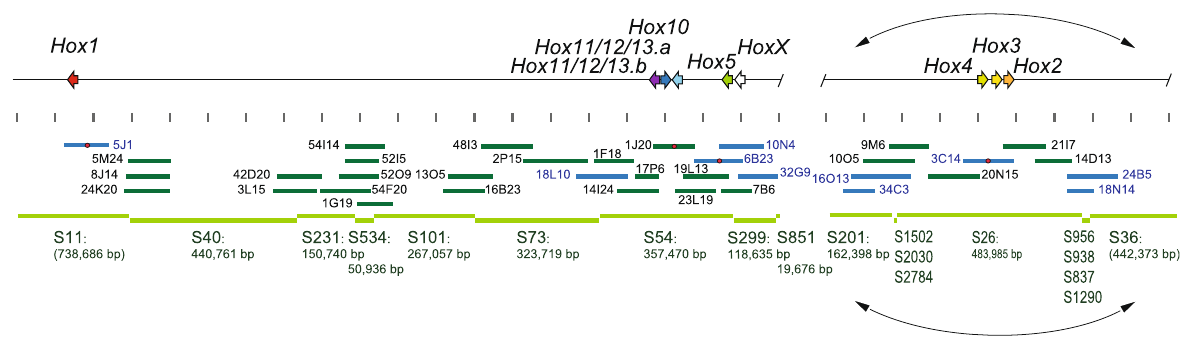
Fig. 4 Schematic representation of the Hox gene cluster of Halocynthia roretzi . The Hox gene cluster structure of Hr as estimated by chromosome/ scaffold walking is shown at the top. A horizontal line represents a part of chromosome. The telomeric side is to the left and the centromeric side is to the right. Hox genes are represented as thick arrows, which also indicate transcription direction. The color code is the same as that in Fig. 1. Between HoxX and Hox4, there is a region, from which no clones were available out of the BAC library; hence, no scaffolds available out of the ANISEED database. Grey arrays of short vertical bars indicate 100 kbp, starting at the right and left ends of the region where no scaffolds are available. Dark green or blue horizontal bars below the scales indicate BAC clones corresponding to Hox gene clusters. Dark green bars indicate BAC clones, end regions of which were sequenced. Blue bars indicate BAC clones for which the whole insert sequence was determined. Bars with red dots in the middle are the clones used for probes for chromosomal FISH (Fig. 3). Names of clones are also indicated. Green horizontal bars at the bottom indicate scaffolds in the ANISEED database ( Halocynthia roretzi MTP2014; https://www.aniseed.cnrs.fr/fgb2/gbrowse/harore_mtp2014/) that correspond to the Hox gene cluster spanning chromosomal region. The length of each scaffold according to ANISEED database is indicated below scaffold names, except for the scaffolds in the two regions adjacent to S26, where multiple small scaffolds are included. Arc lines with arrowheads on both ends placed upper and lower of the subcluster region of Hox2, 3 and 4 indicate that the orientation of the subcluster has not been